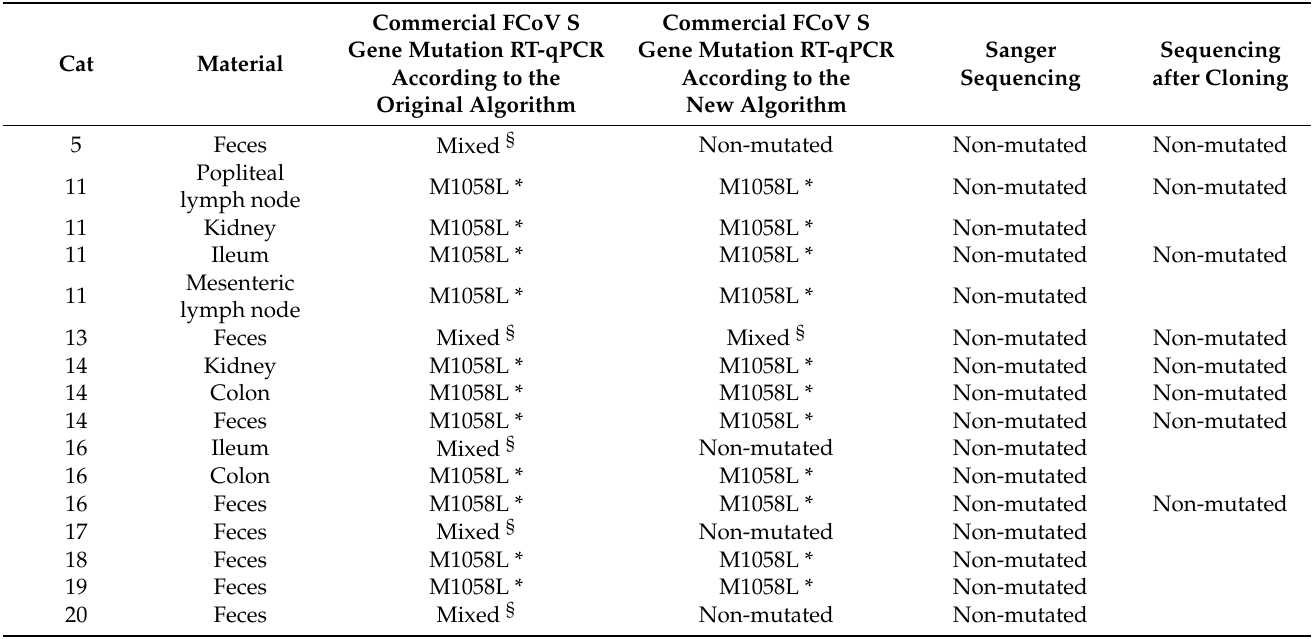
Table 3. Results of the commercial real-time feline coronavirus (FCoV) spike (S) gene mutation reverse transcription polymerase chain reaction (RT-qPCR) and corresponding Sanger sequencing and cloning in the 16 samples (8 tissue and 8 fecal samples) of 9 nine cats that could be successfully